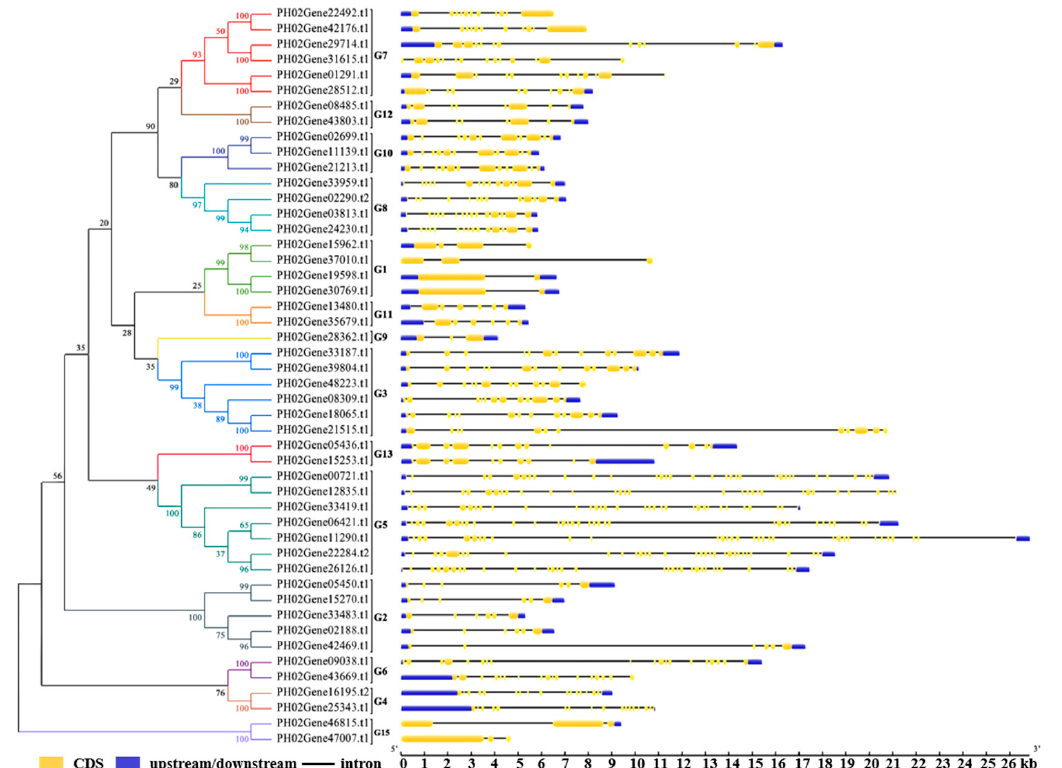
Figure 3. Phylogenetic relationship and gene structures of PeUBPs in moso bamboo. Left: Phylogenetic tree of PeUBPs constructed using the Neighbor-joining method based on the results of a sequence alignment. Bootstrap values from 1000 replicates are indicated at each node. The proteins in the tree were divided into 14 distinct subfamilies, and the branches of different subfamilies are marked using different colors. Right: Exons, introns, and untranslated regions (UTRs) are indicated by yellow rectangles, gray lines, and blue rectangles, respectively.